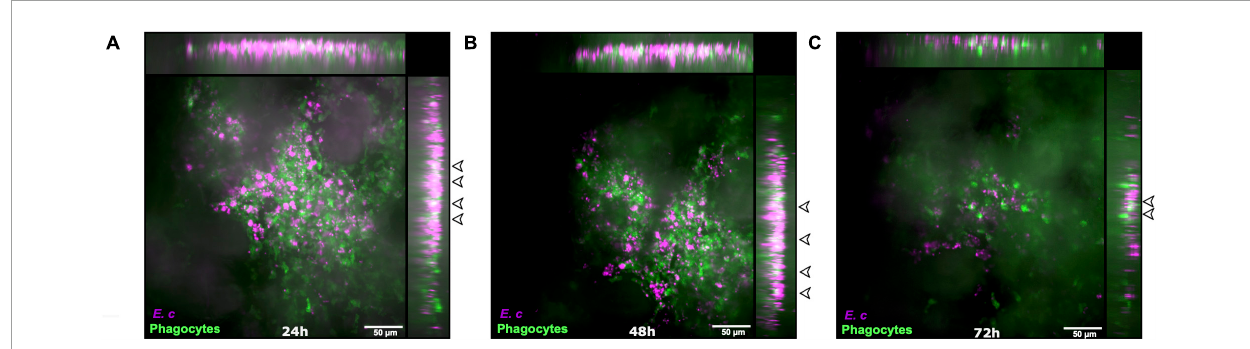
FIGURE4 Parasite maintenance in the mouse ear pinna after inoculation of Encephalitozoon cuniculi spores. Live confocal imaging after micro-injection of E. cuniculi spores in the ear pinna of LysM-EGFP transgenic mice 24 h (A) , 48 h (B) , and 72 h (C) pi. Images show average intensity projections of green (phagocytes) and blue (parasites) fluorescence. Some intracellular parasites appear in white (overlap of green and blue fluorescent signals, empty arrowheads). Cluster of cells interacting with spores are observed at all-time points. Empty arrowheads indicate the presence of remaining parasites from 24 h to 72 h pi. Four independent experiments, n = 8 tissues ( E. c ) and n = 14 control tissues (PBS). Scale bar: 50 µ m.